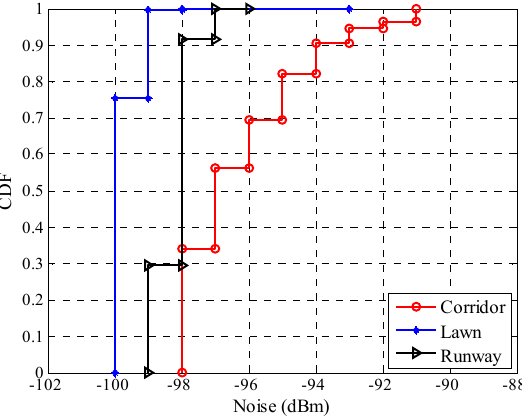
Figure 14. CDFs of the background noise in different environments.